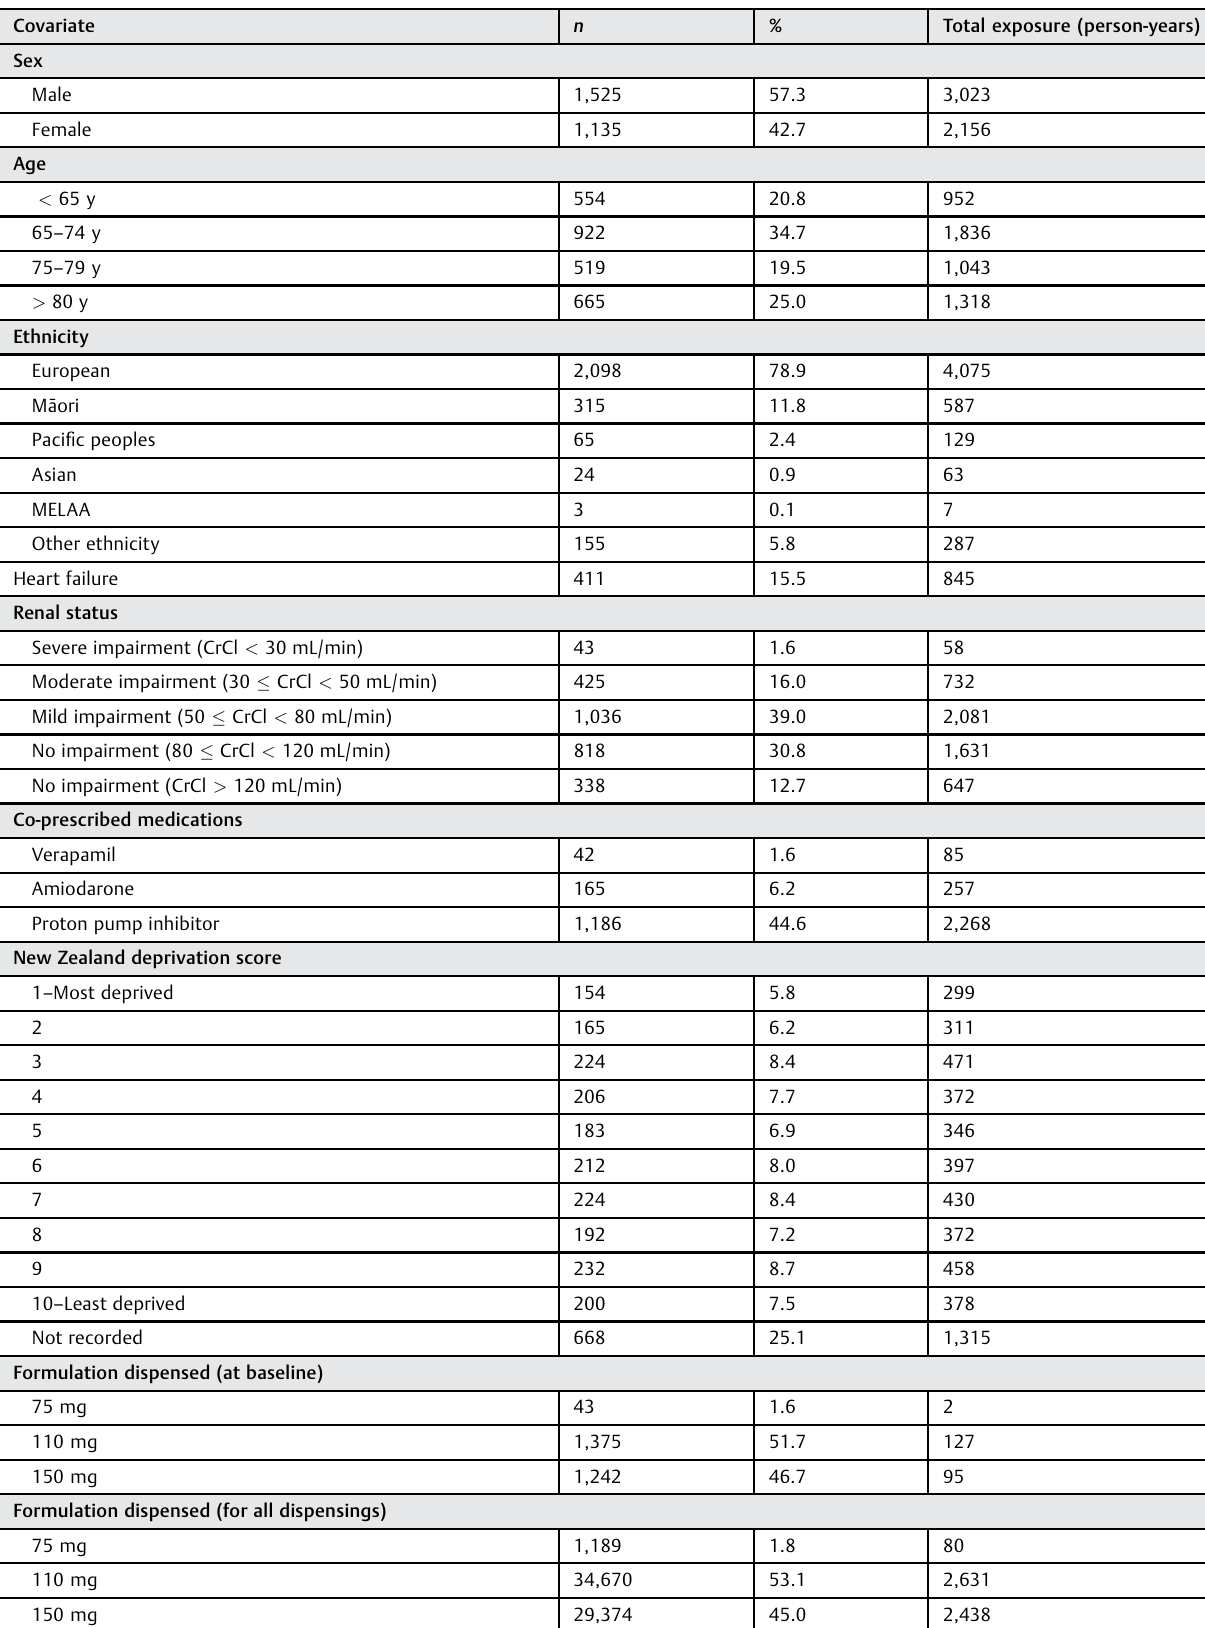
Table 1 Individual patient covariate information